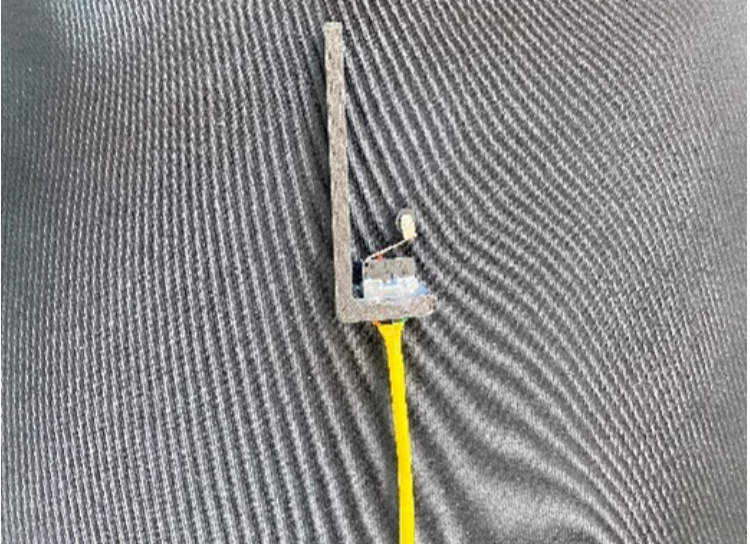
Figure 6. The physical photo of the limit